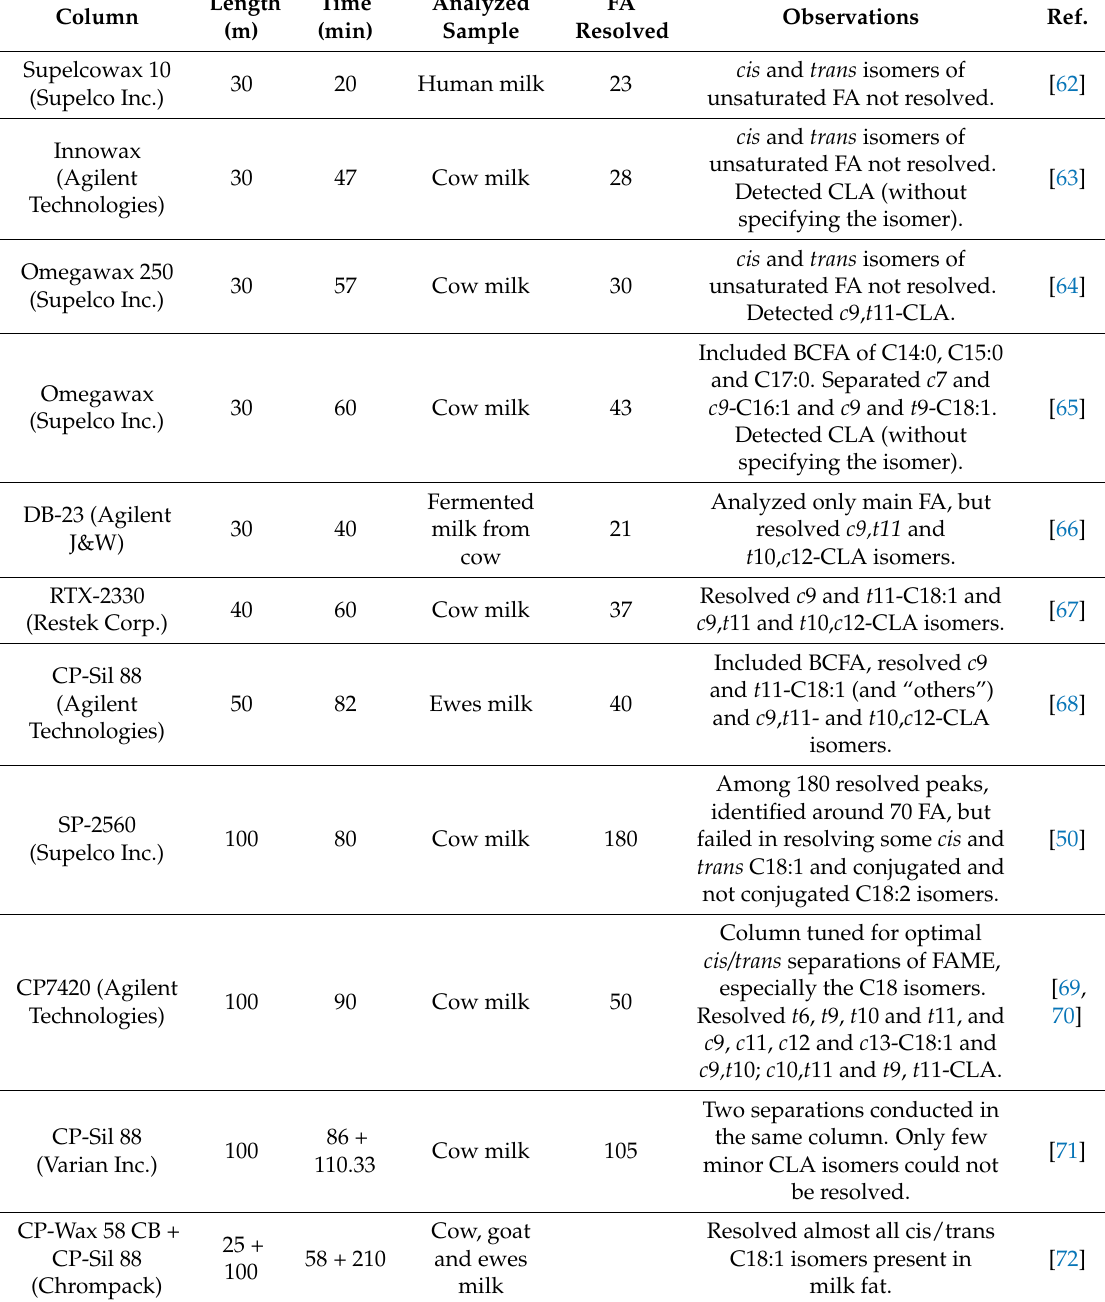
Table 2. Some representative examples of the use of GC 1 columns for the analysis of FA 2 in milk and dairy